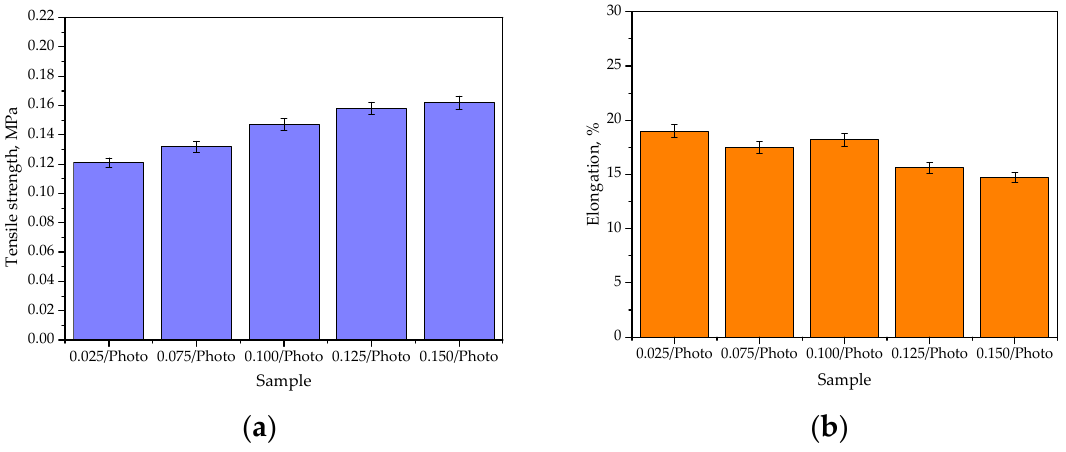
Figure 6. The percentage elongation ( a ) and the tensile strength ( b ) of hydrogels (the study was performed in triplicate, n = 3). Table 3. Results of the statistical calculations, calculated using the ANOVA method. Independent Variable